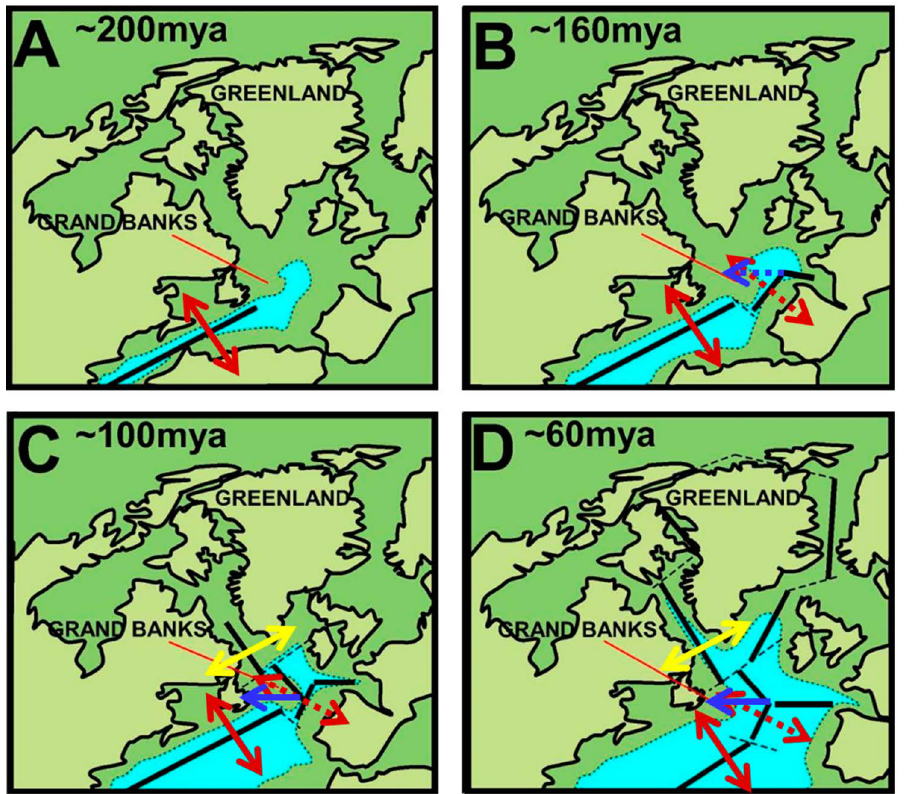
Figure 2. North Atlantic Rifting Evolution. ( A ) 200 Ma ( B ) 160 Ma ( C ) 100 Ma ( D ) 60 Ma. Extensional stress directions for each rifting episode appear as double-headed arrows with colors red, yellow and blue corresponding to initial (Tethys), intermediate (N. Atlantic) and final (Labrador) rifting phases, respectively. Light blue regions represent the proto-Atlantic opening up. Redrafted from original figure in [14] with arrows